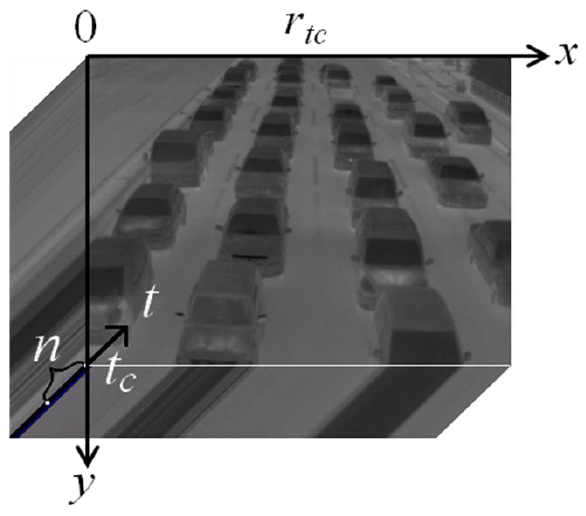
Figure 4. An example of spatio-temporal images.